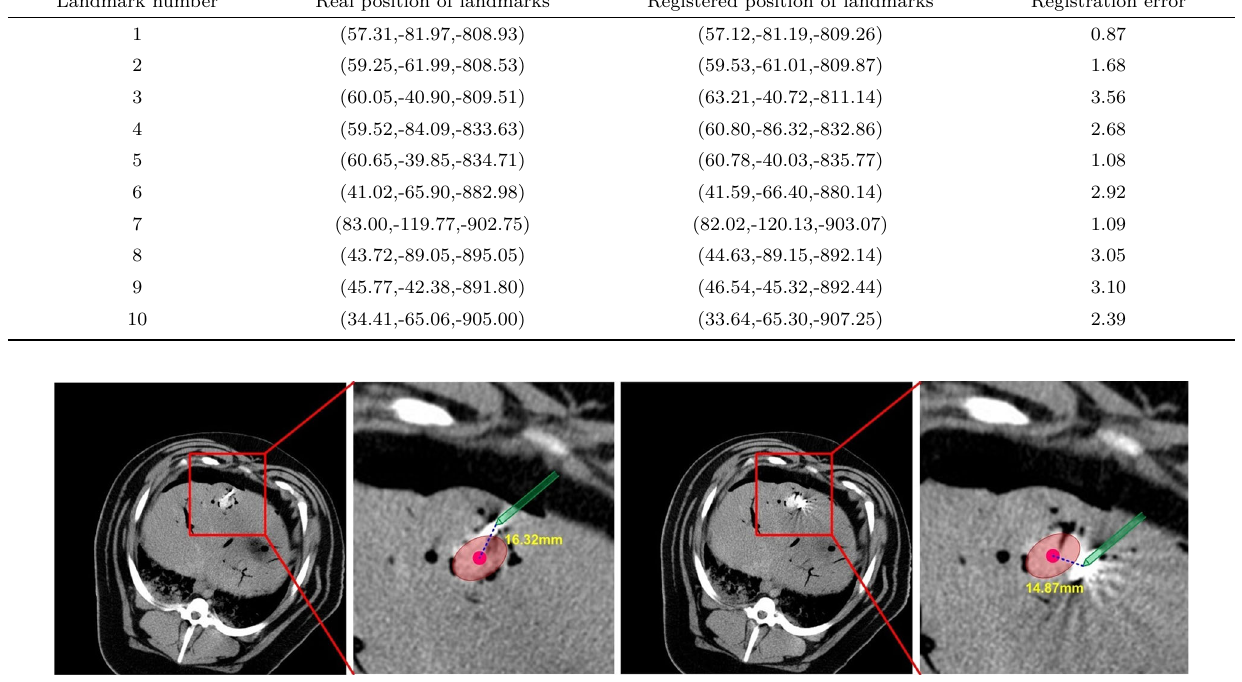
Fig. 7 Results of traditional CT-navigated needle insertion.